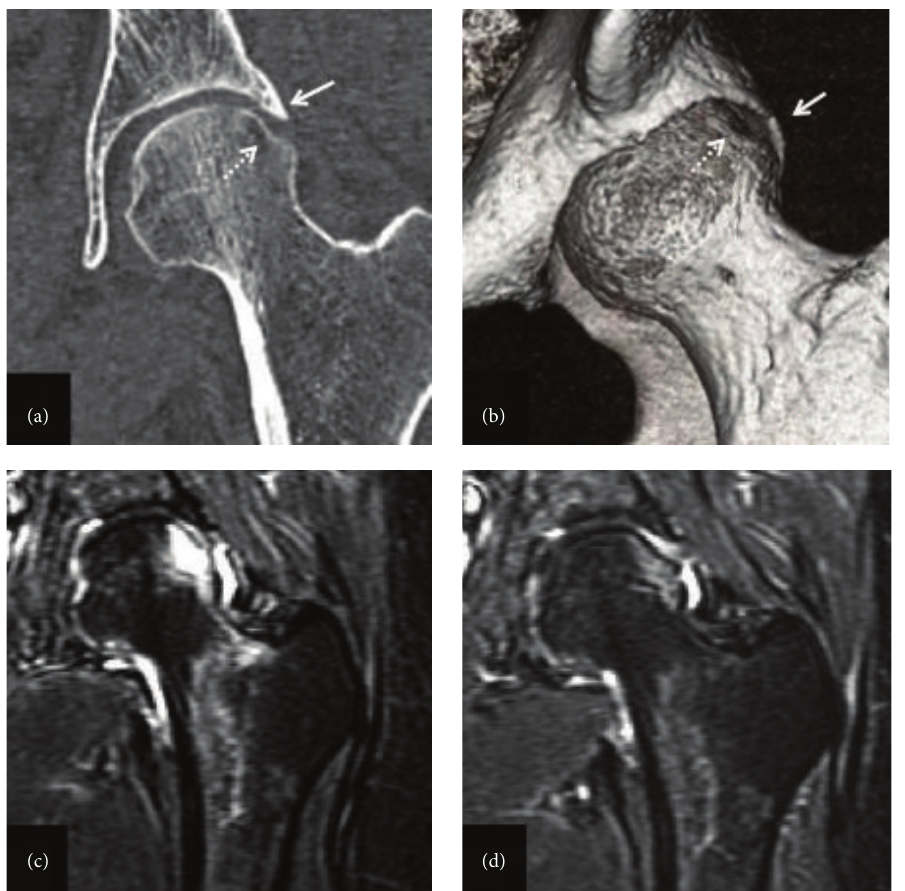
Figure 2: Partial collapse of the femoral head and serial MRI images. (a) Coronal computed tomography (CT) image after 4 weeks of therapy showssubchondralcollapse(whitedottedarrow)attheantipodesofthelateralizedrim(whitearrow).(b)Asubchondralinsufficiencyfracture (SIF) is evident at the posterolateral aspect of the femoral head in the oblique three-dimensional CT view. STIR images show that the high intensity lesion (c) is smaller after 10 weeks of therapy and (d) has almost disappeared after 4 months of therapy.